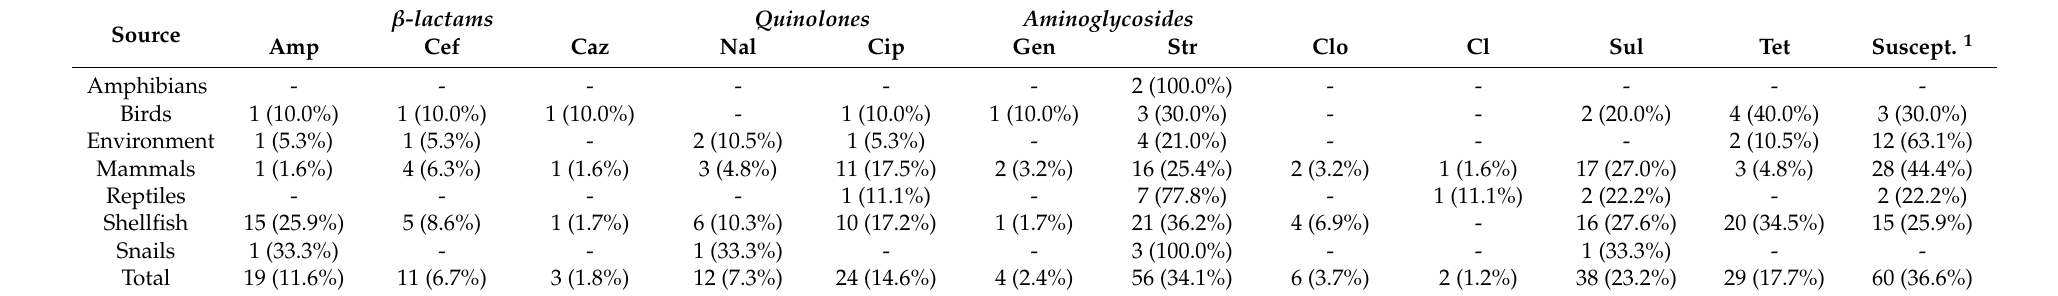
Table 3. Overall occurrence (n.) and percentage (%) of resistance to 11 antibiotics (ampicillin (Amp), cefotaxime (Cef), ceftazidime (Caz), nalidixic acid (Nal), ciprofloxacin (Cip), gentamicin (Gen), streptomycin (Str), chloramphenicol (Clo), colistin sulfate (Cl), trimethoprim-sulfamethoxazole (Sul) and tetracycline (Tet)) in Salmonella spp. from amphibians (frogs), birds, environment, mammals, shellfish, reptiles and